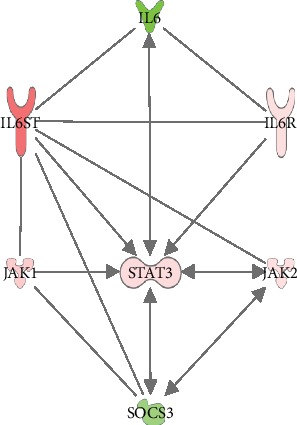
Knockdown of IL6 in human endothelial cells affects the gene expression of proteins known to be involved in IL6-mediated signaling. Knockdown of IL6 was performed using siRNA-mediated gene silencing followed by RNA sequencing in cultured human vascular endothelial cells. The impact of IL6 knockdown on genes known to be central in IL6 signaling (IL6 core genes) was investigated. Green symbols indicate downregulated genes, and red/pink symbols indicate upregulated genes. Pathway and coloring were generated using Ingenuity Pathway Analysis software.